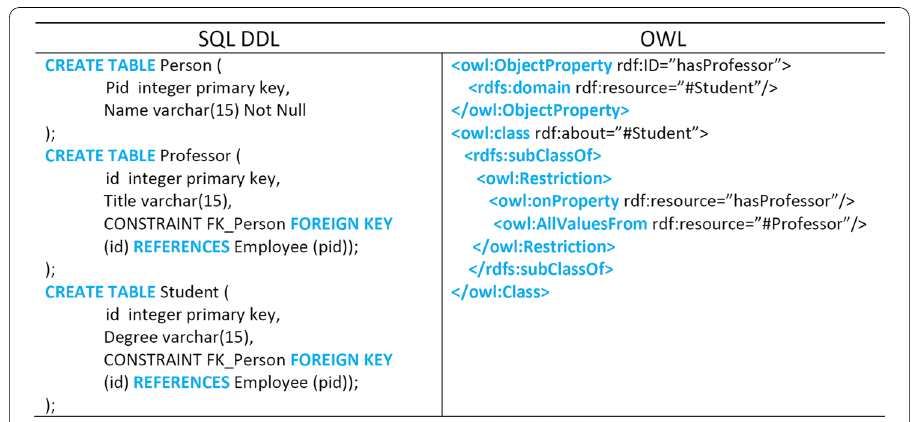
Fig. 5 Improvement of the inheritance relationship